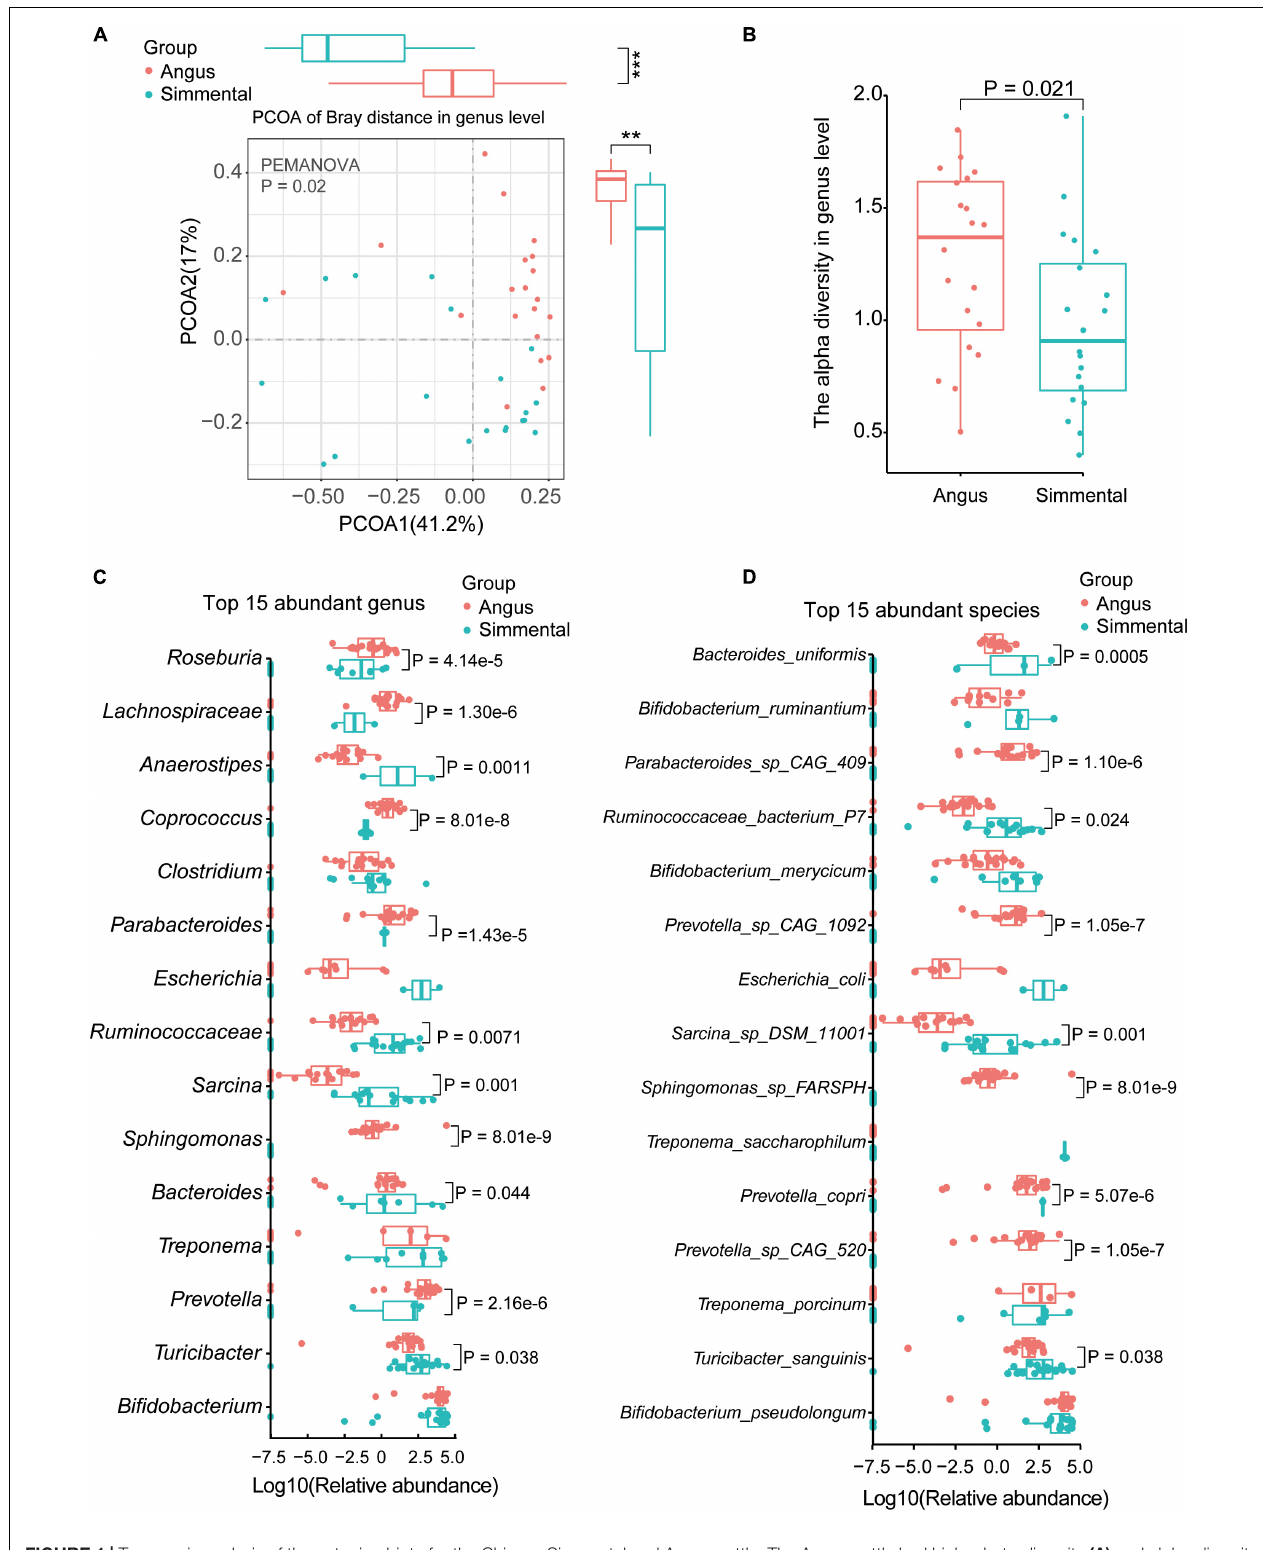
Frontiers in Microbiology |